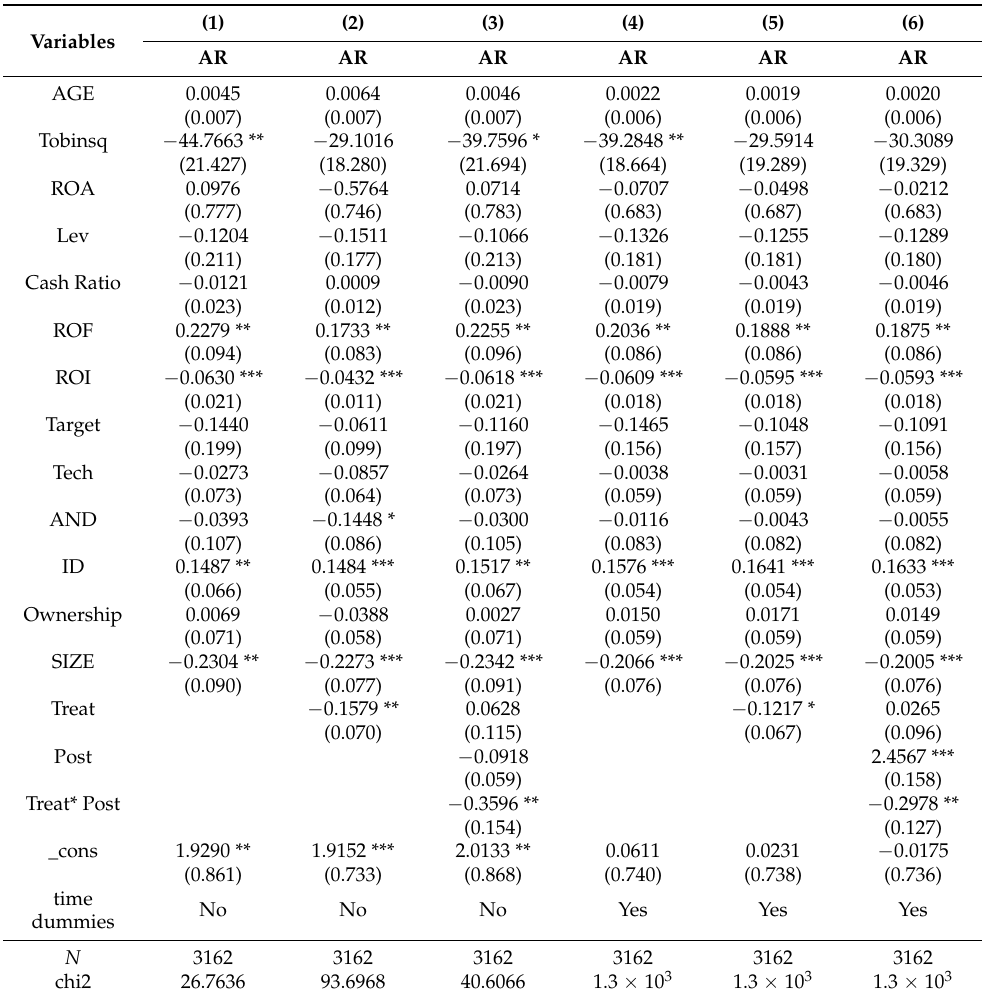
Table 7. PSM-DID regression